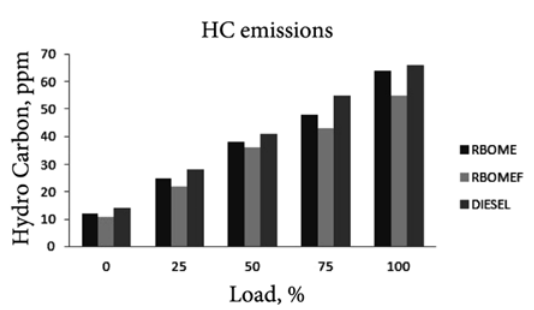
loadFig. 2. Hydro carbon emissions with respect to load